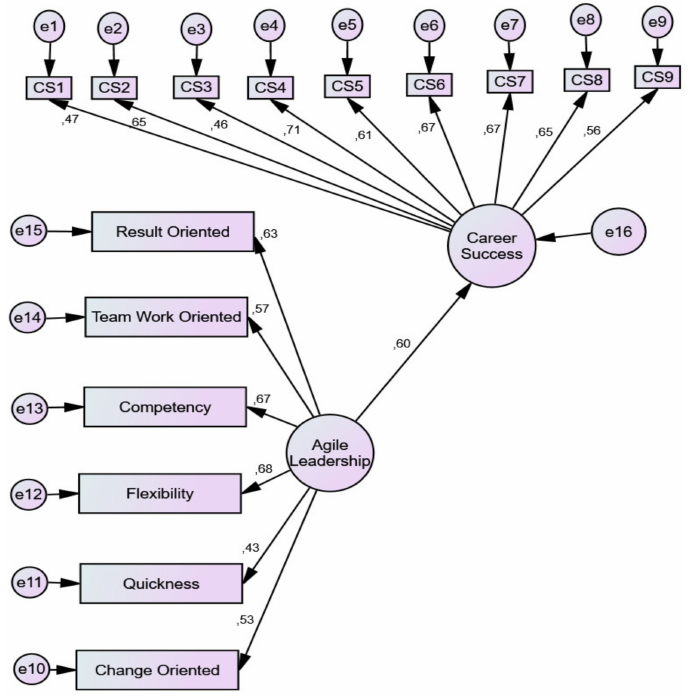
Figure 2. Direct effect of agile leadership on career